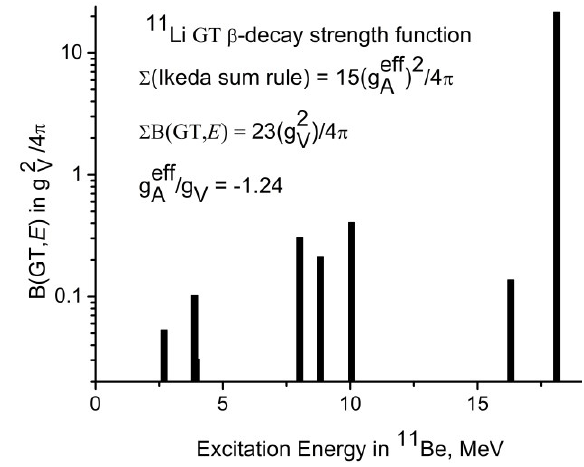
Table 1. 11 Li. (g.s I π =3/2 – ) β - – decay , ( g Aeff / g V ) 2 = 1.5  0.2,